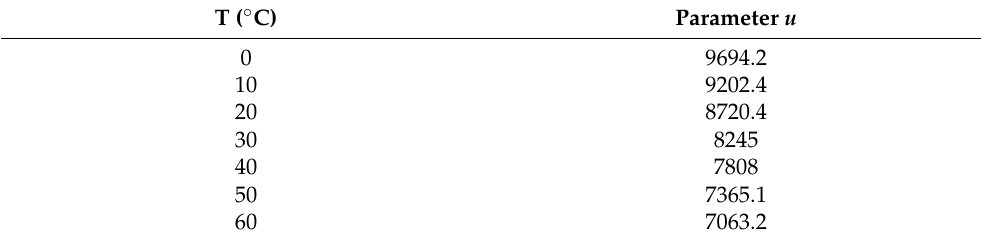
Table 3. Relationship between the parameter u and temperature T.